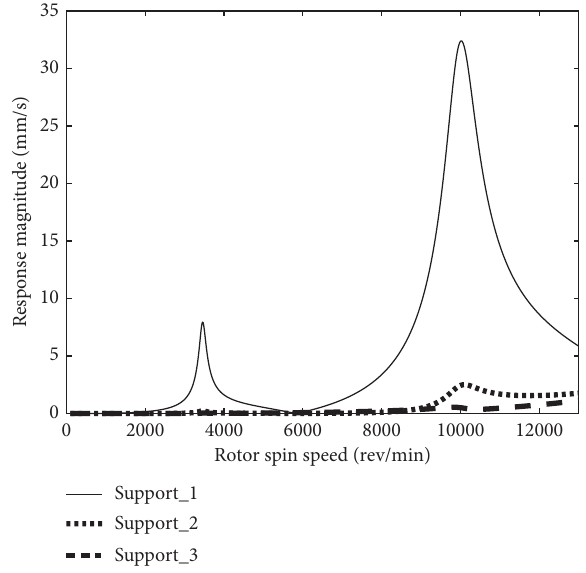
Figure 8: The frequency response functions at support_1, sup- port_2, and support_3. Table 2: The operating speeds.